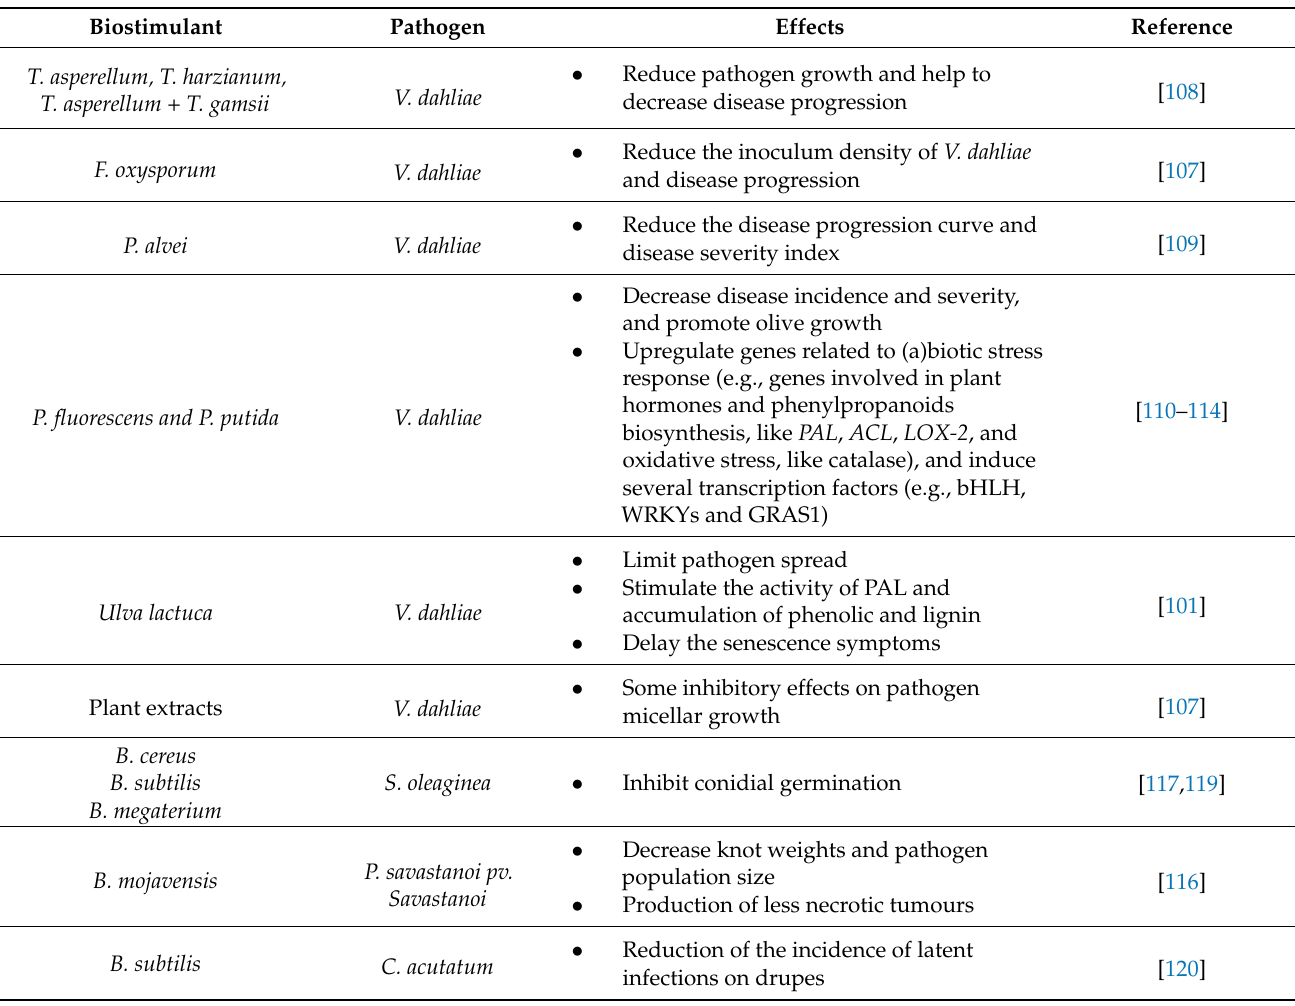
Table 2. Biostimulants used in the control of some olive